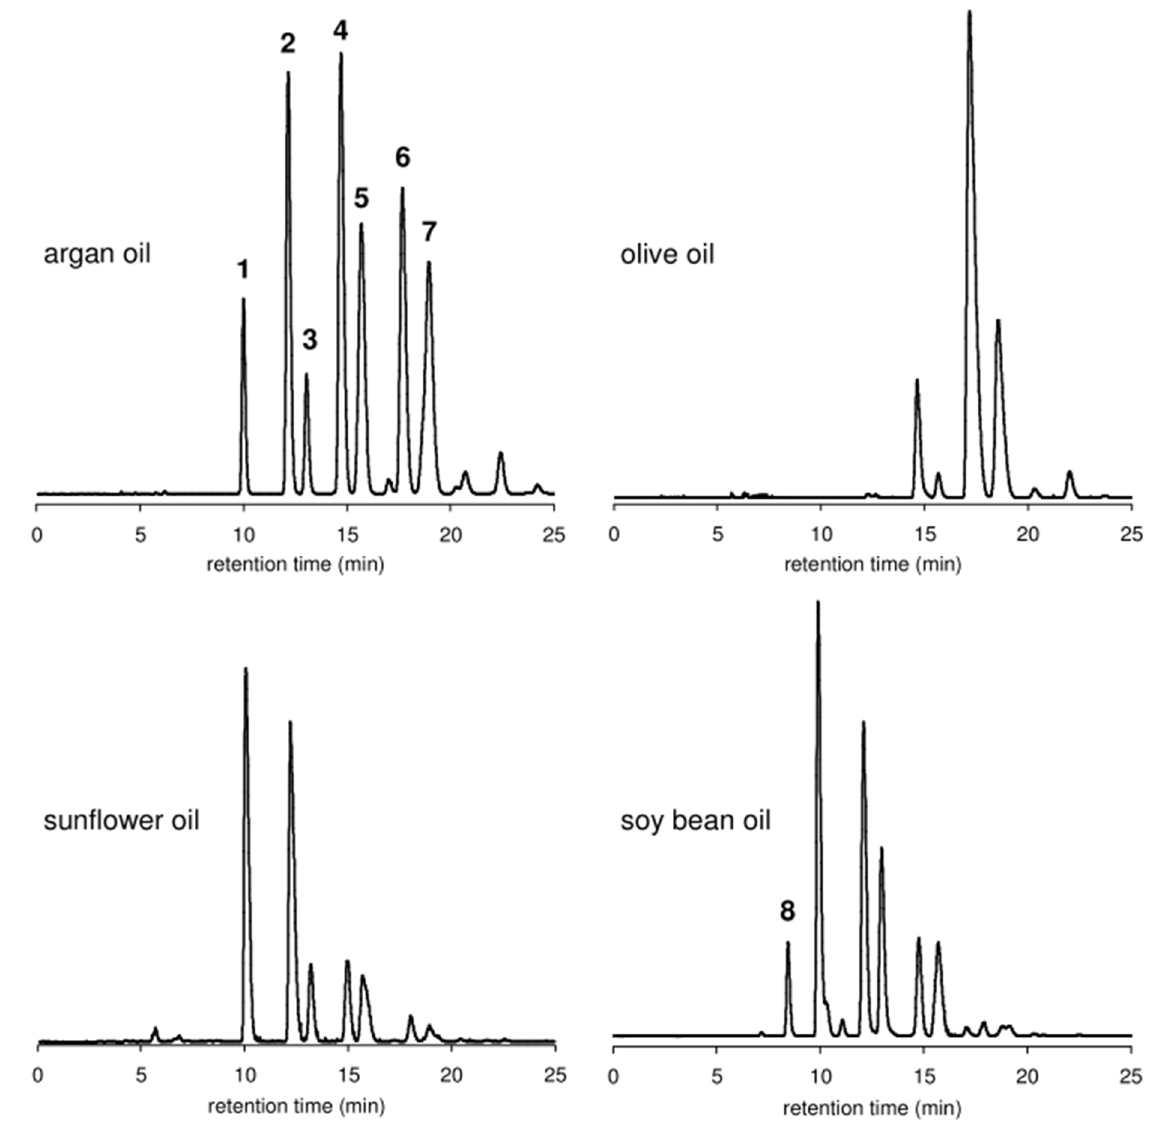
Figure 3. HPLC ‐ ELSD chromatograms of triacylglycerols from Argan oil, olive oil, sunflower oil, and soybean oil (peaks were not identified). Reproduced with permission from Ref. [80]. Table 5. Chromatographic techniques to detect adulteration in Argan oil: targeted analysis.